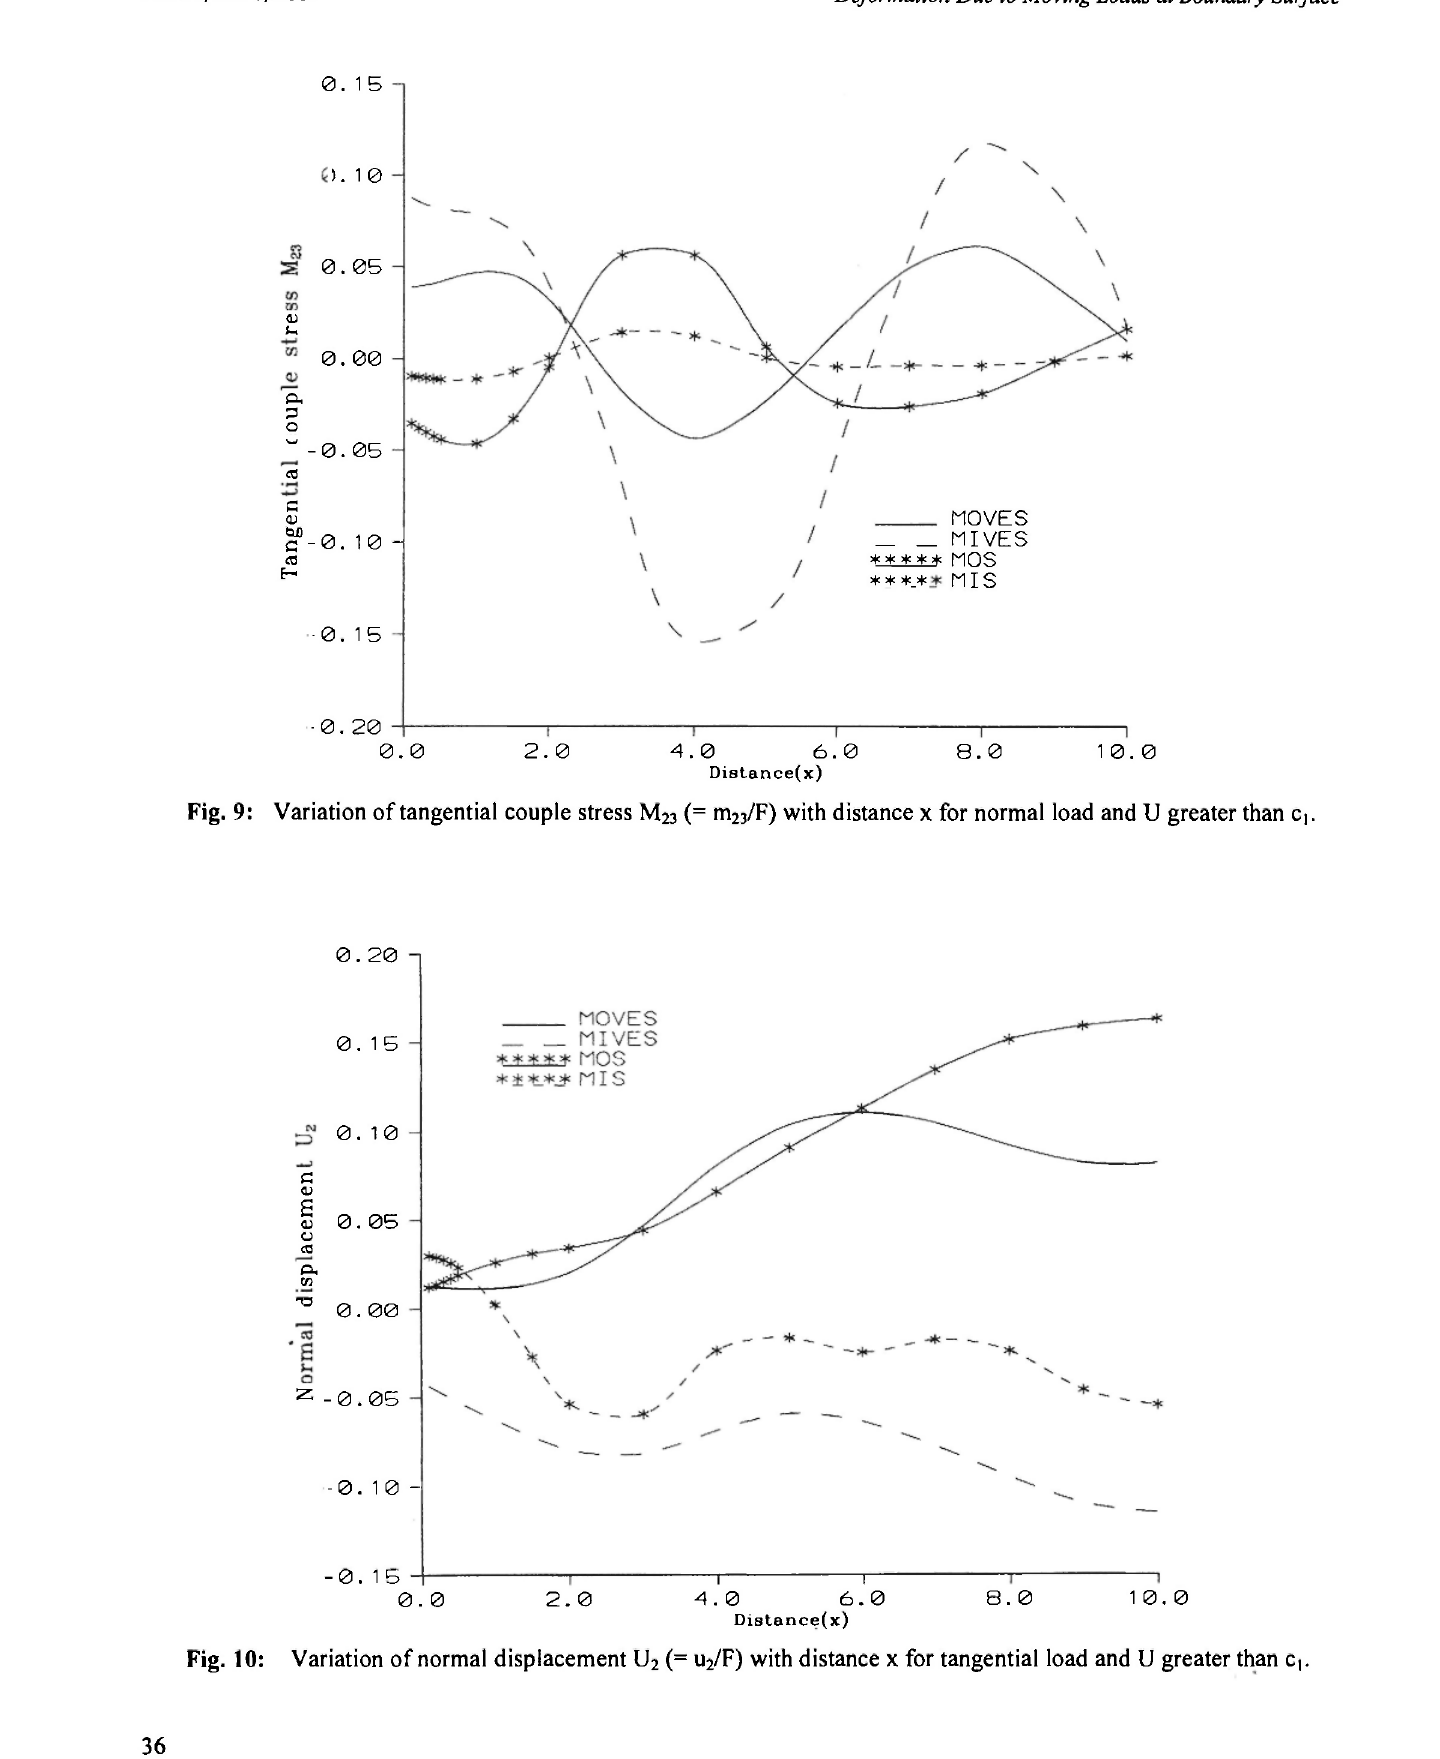
Fig. 10: Variation of normal displacement U 2 (= u 2 /F) with distance χ for tangential load and U greater than c,.